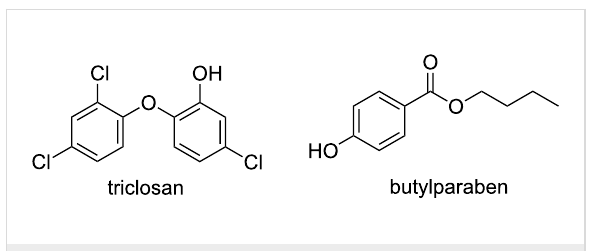
Figure 7: Chemical structures of triclosan and butylparaben.